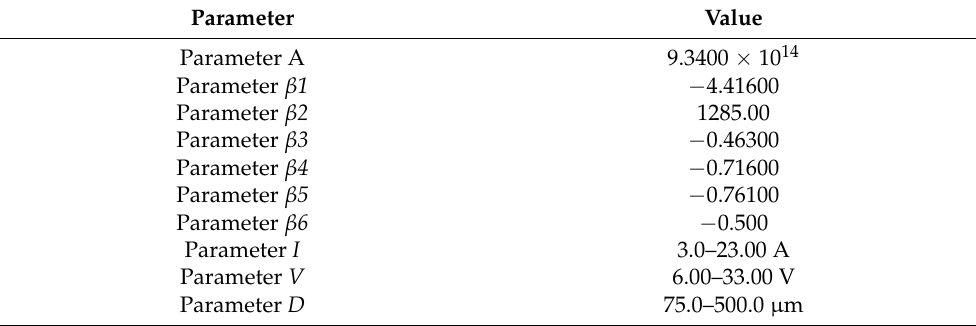
Table 1. Parameters of Bayerer’s